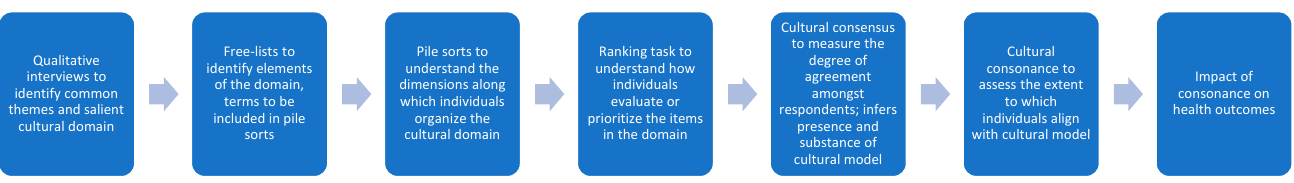
Figure 1. Step-by-step data collection and analysis process.